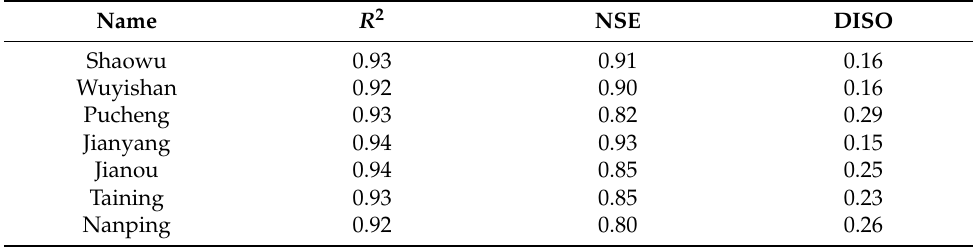
Table 2. Applicability assessment of the GLDAS ET a